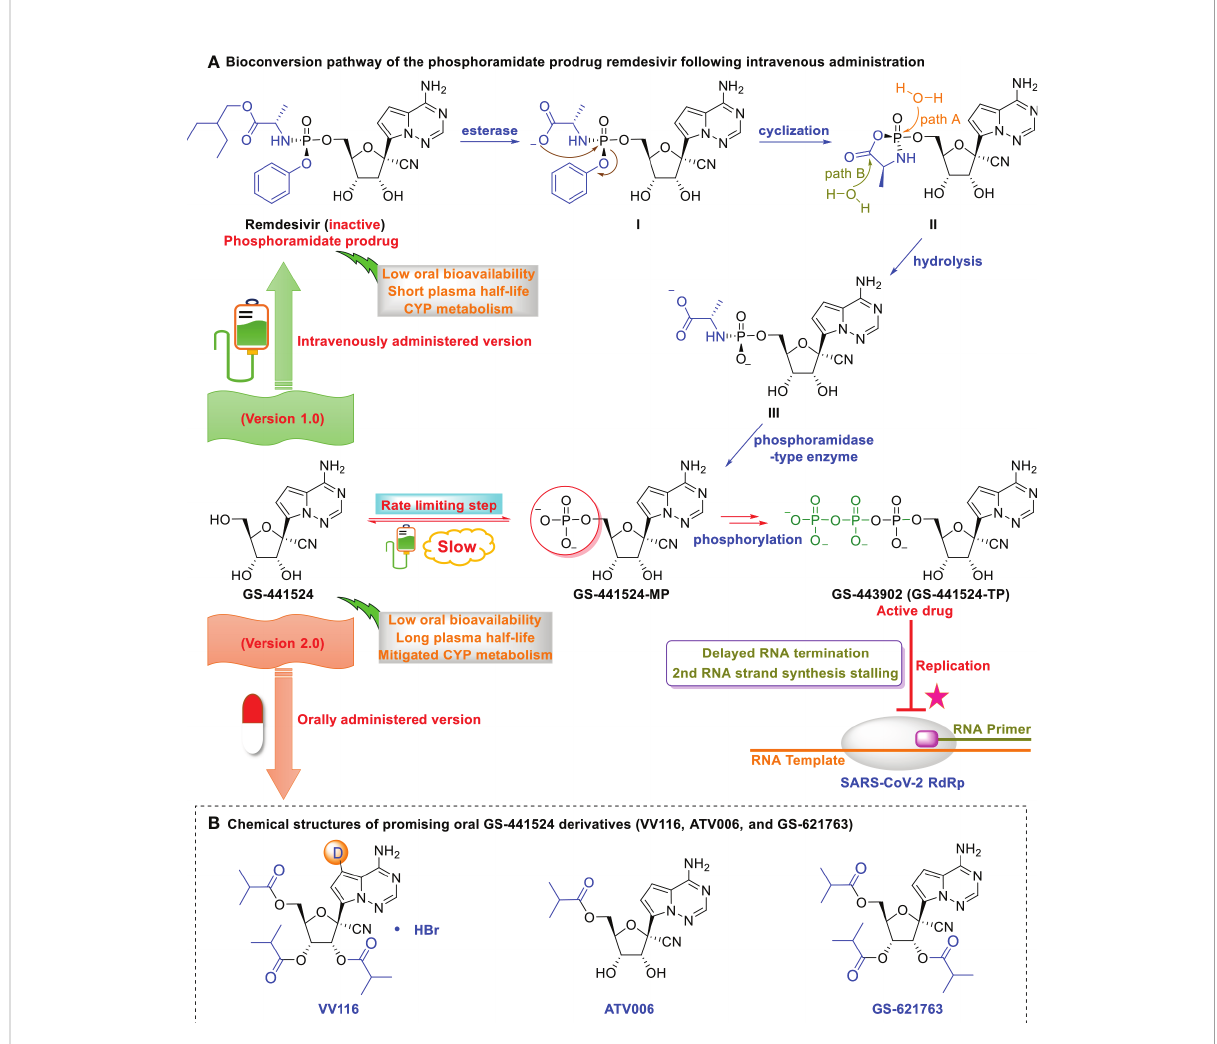
FIGURE 1 Optimizationof GS-441524 forintravenousremdesivirandthe oralversion, VV116. (A) Bioconversionpathway of